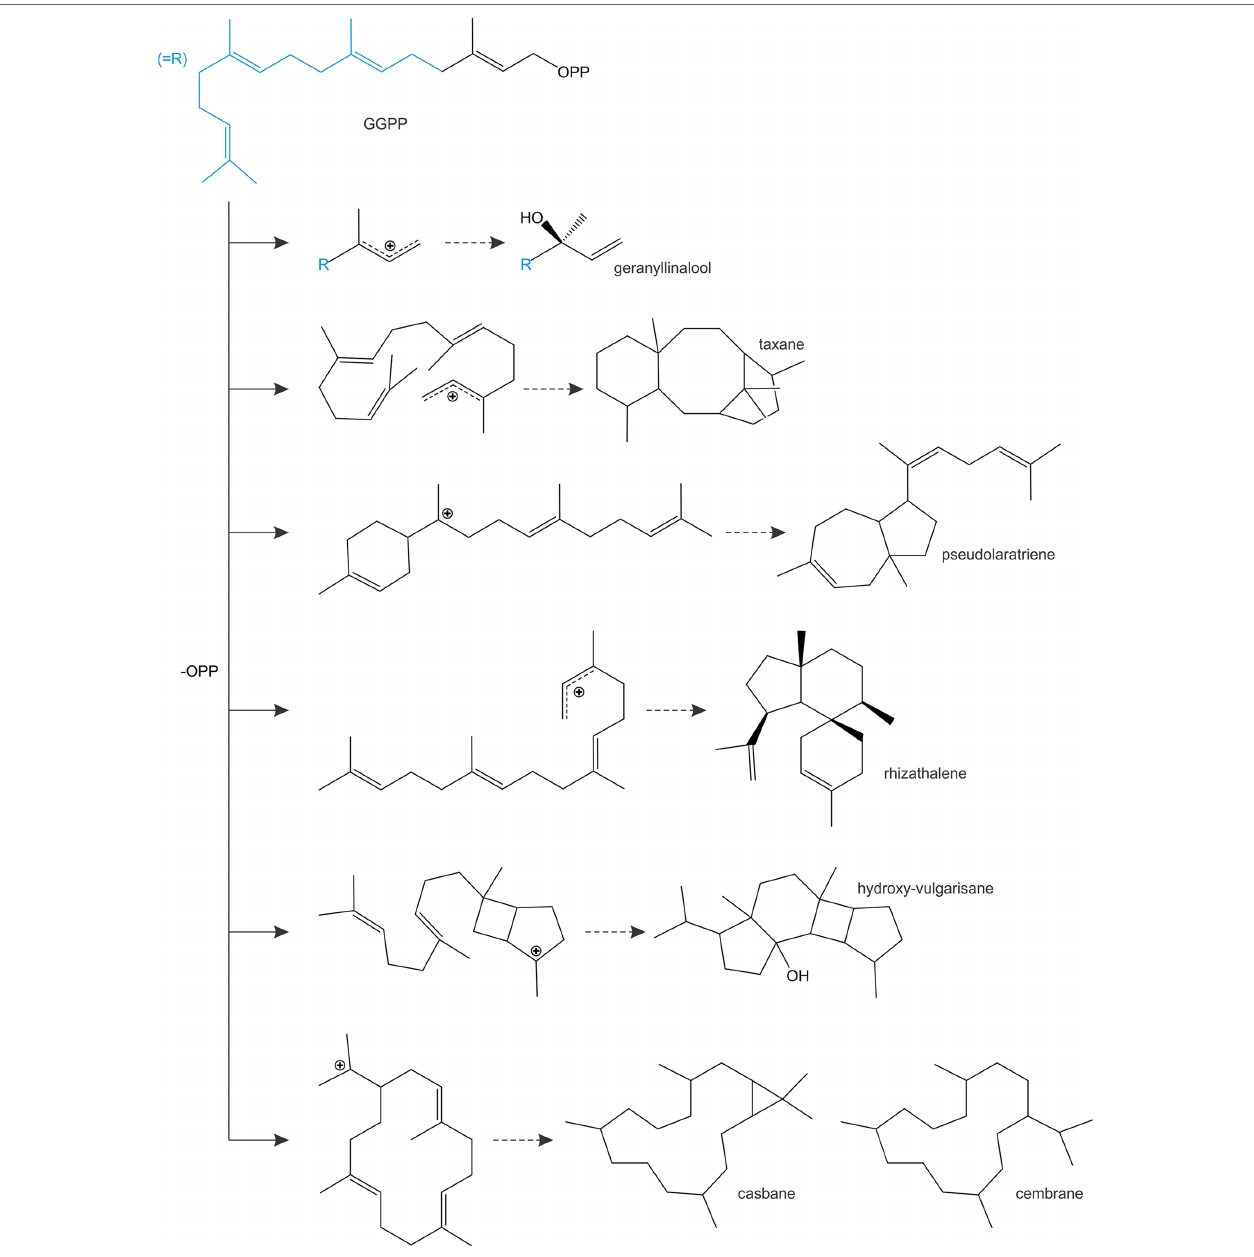
FIGURE 5 | Schematic overview of prominent linear, polycyclic and macrocyclic diterpene scaffolds that are formed through the activity of monofunctional class I diTPSs that are capable of directly converting geranylgeranyl diphosphate (GGPP) as a